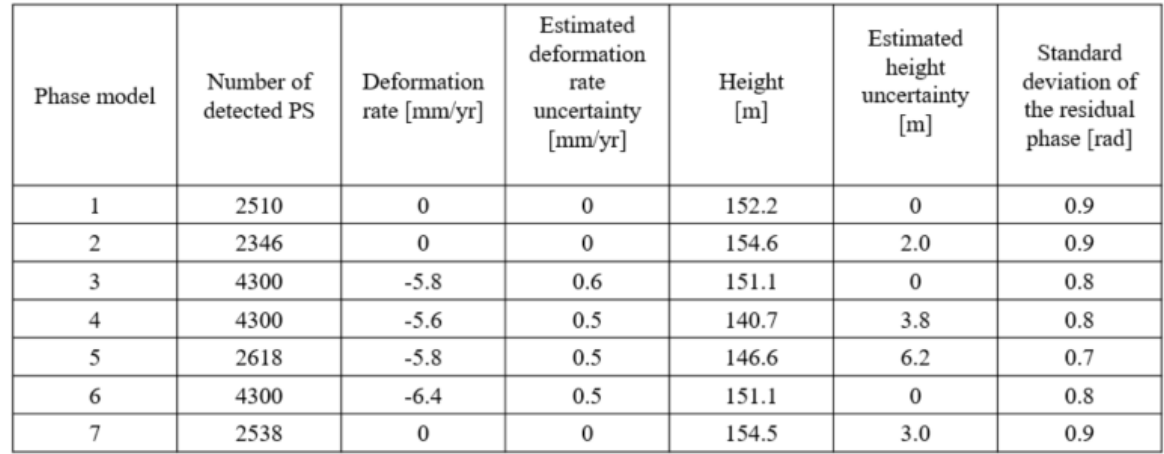
Table 3: Estimated parameters for each model at the specific location of Figure 4 (red